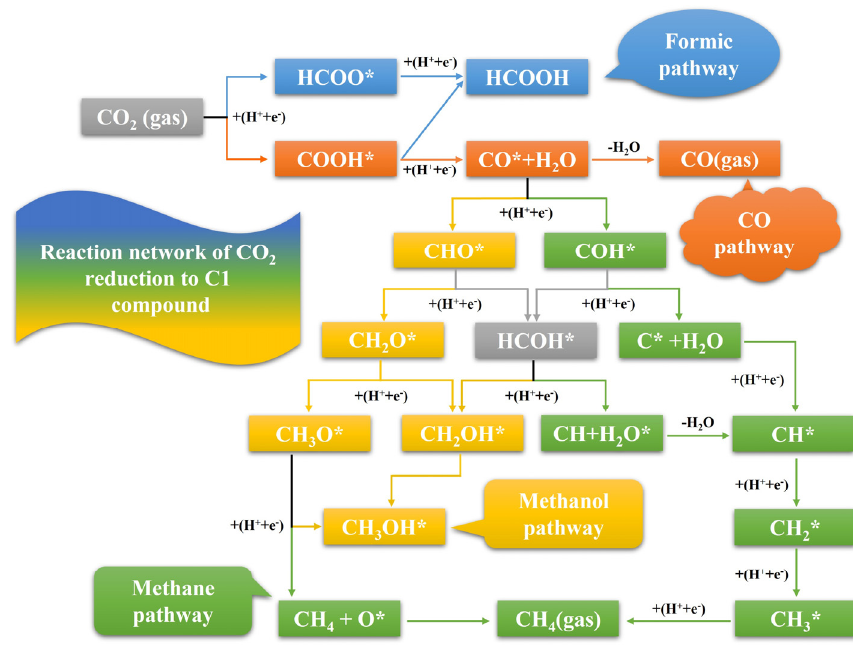
Figure 1. The overview of all possible pathways for CO 2 reduction to C1